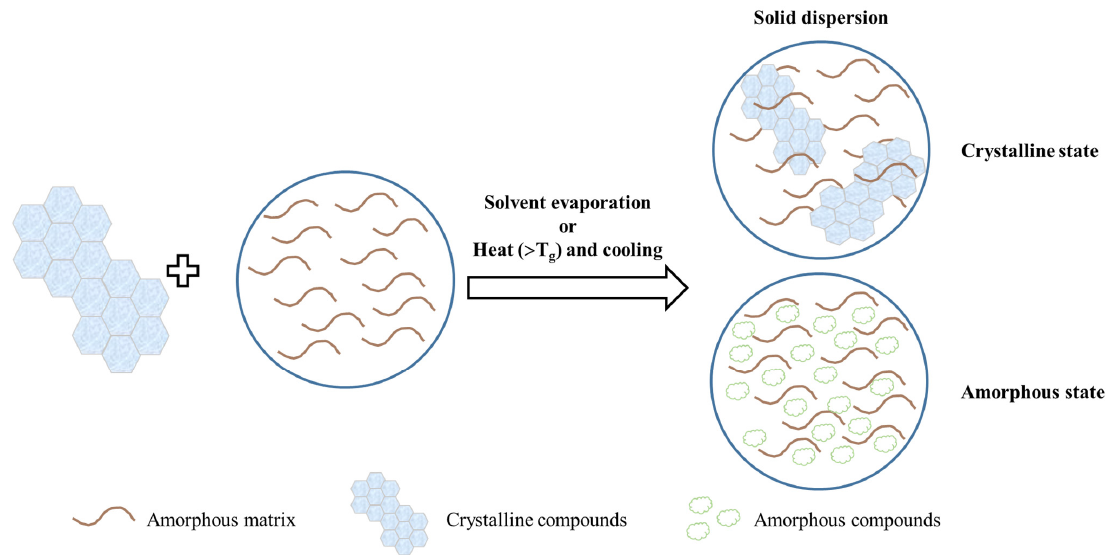
Figure 8. The scheme of solid dispersions.